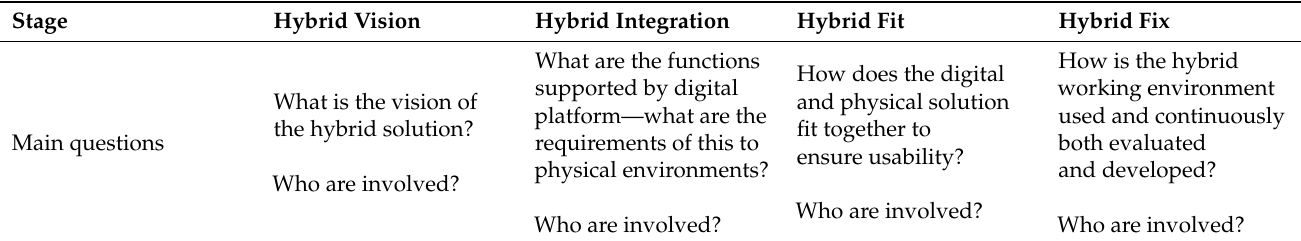
Table 5. The Entry Point Analysis (EPA)-tool for co-design in the hybrid working environments. Stage Hybrid Vision Hybrid Integration Hybrid Fit Hybrid Fix